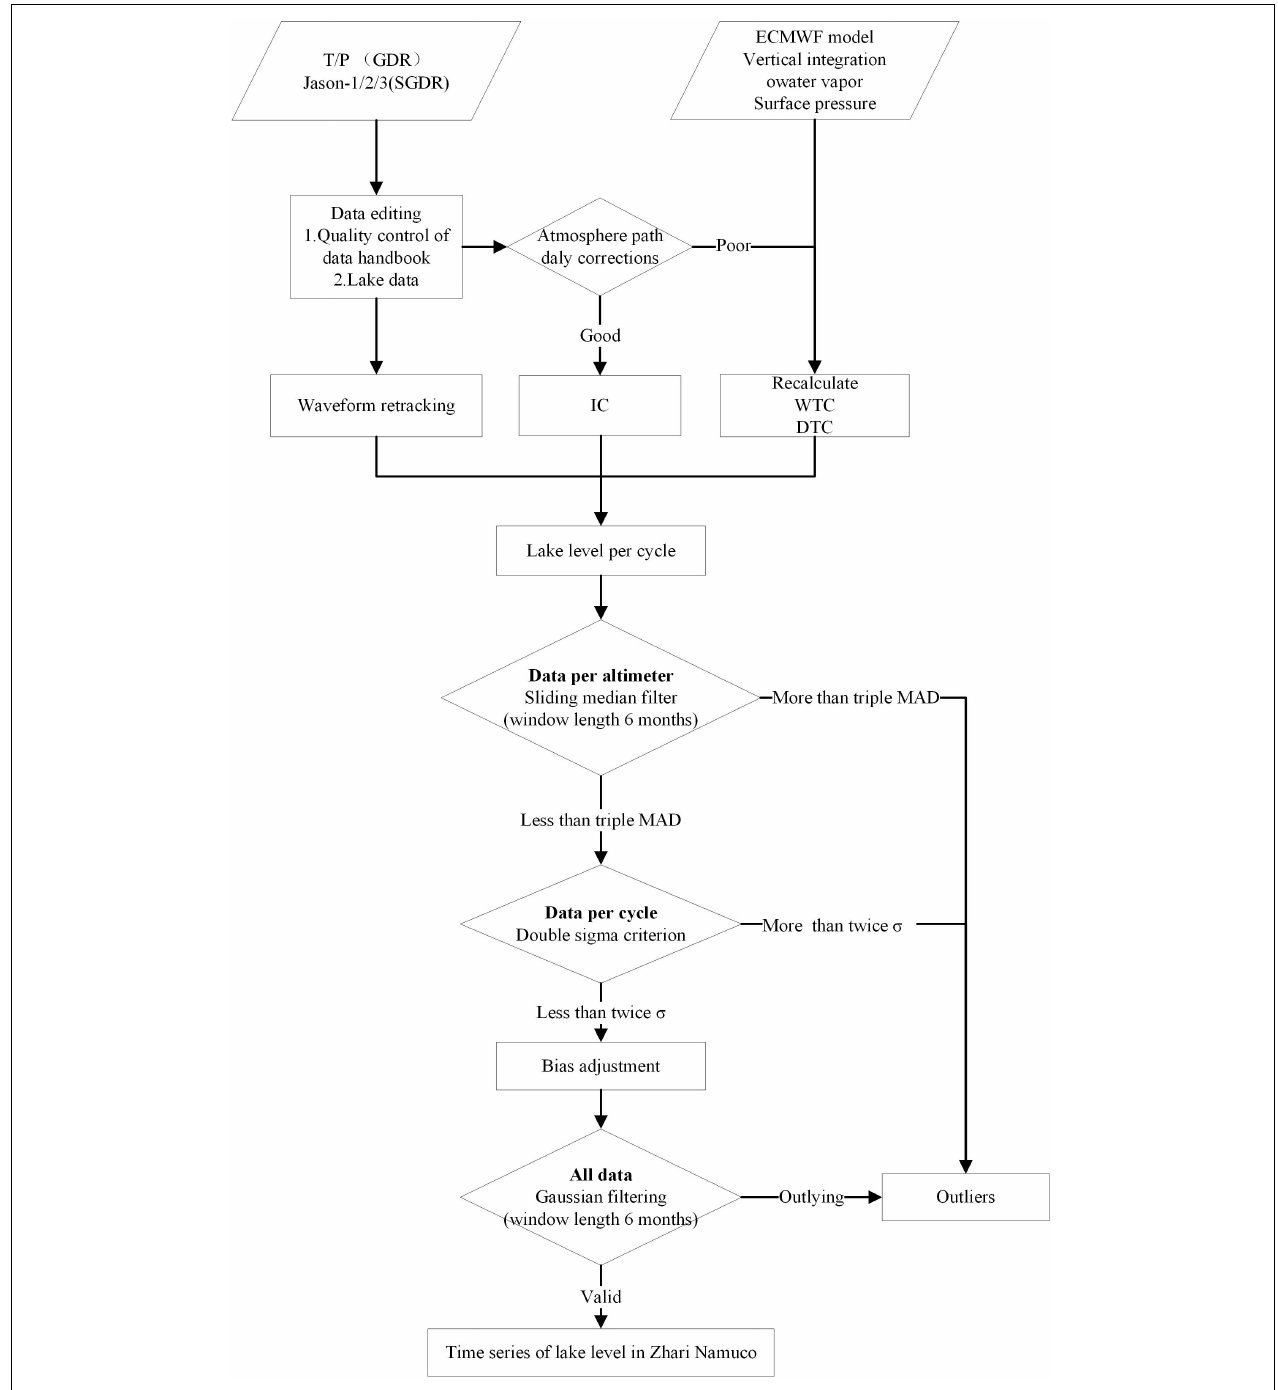
FIGURE 2 | Satellite altimetry processing